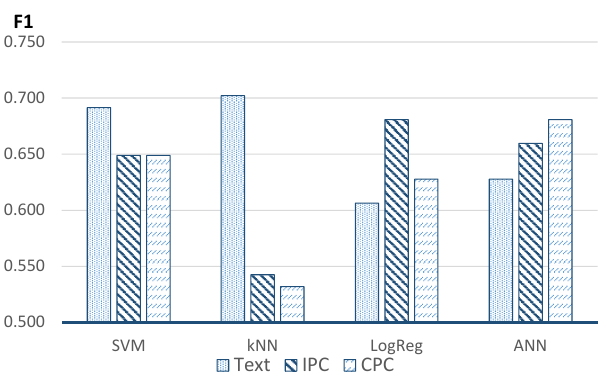
Figure 4. Performance of four different base classifiers using text or taxonomic (IPC, CPC) features comparing the overall F1 scores. Biomedical patents of the test data set were classified. IPC: International Patent Classification.